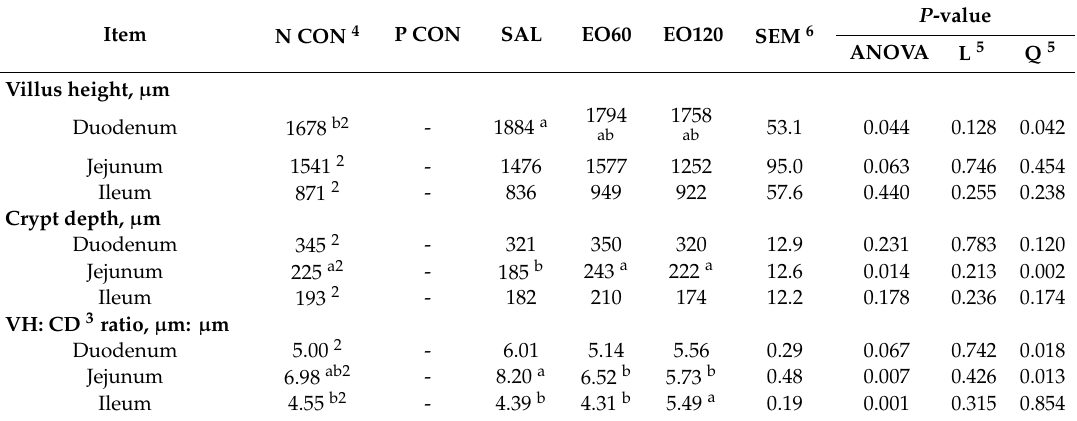
Table 3. E ff ect of supplementation of encapsulated essential oil on morphology of small intestine in naïve broiler chickens 1.